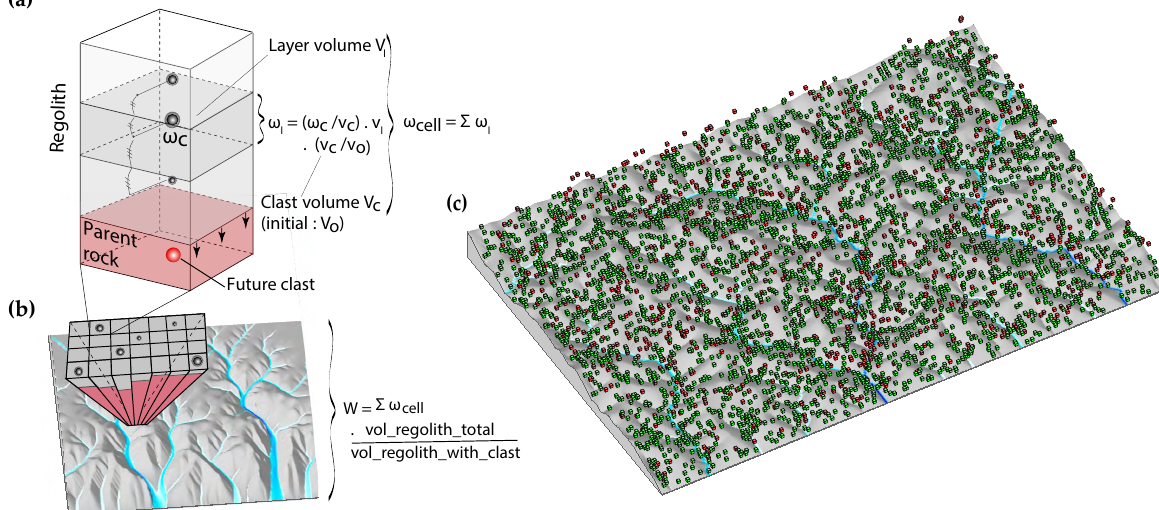
Figure 2. Calculation of the weathering outflux by integrating clast weathering on the cell and mountain scales. (a) A regolith + bedrock soil column containing three clasts in the regolith at a particular time step. Three layers were defined with a size depending on the spacing between the clasts, which itself results either from an initial disposition in the bedrock or from the erosion–deposition history. The equations indicate how the integration on the layer and regolith scales proceeds. The same operation is performed for deposits. w c : clast weathering rate; w l : layer weathering rate; w cell : cell weathering rate; all (L 3 T − 1 ). (b) Once the calculation of all w cell values is completed, the mountain-scale weathering rate W (L 3 T − 1 ) is estimated by taking into account the spatial distribution of the clasts. (c) Example of the reference experiment WARM at 15Ma where the clasts in green are actively dissolving, and the clasts in red are still in the fresh bedrock. Only half of the clasts (5000) are plotted